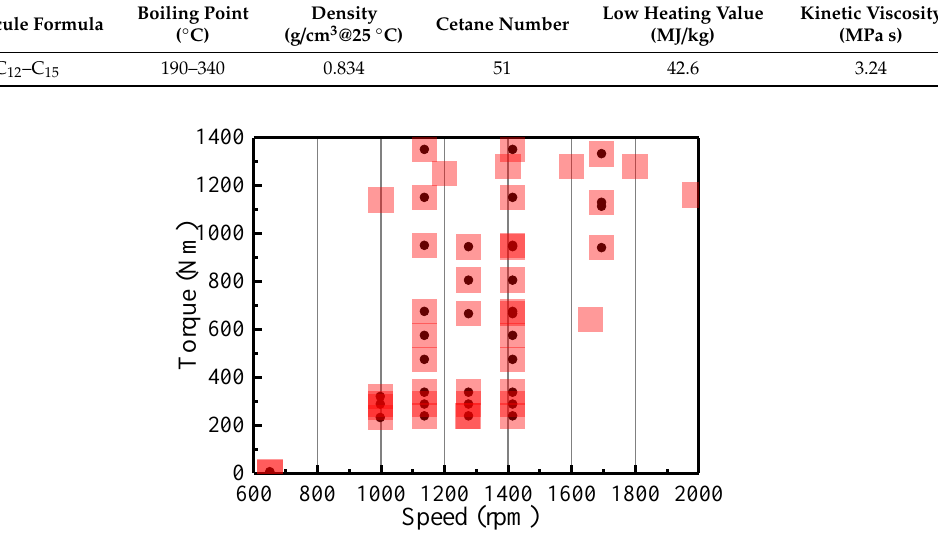
Table 2. Major physical properties of diesel. Figure 4. Driving cycles of all testing data. Figure 4. Driving cycles of all testing data. Table 3. Sensitivity of combustion control Table 1. Engine specifications. Table 3. Sensitivity of combustion control parameters.